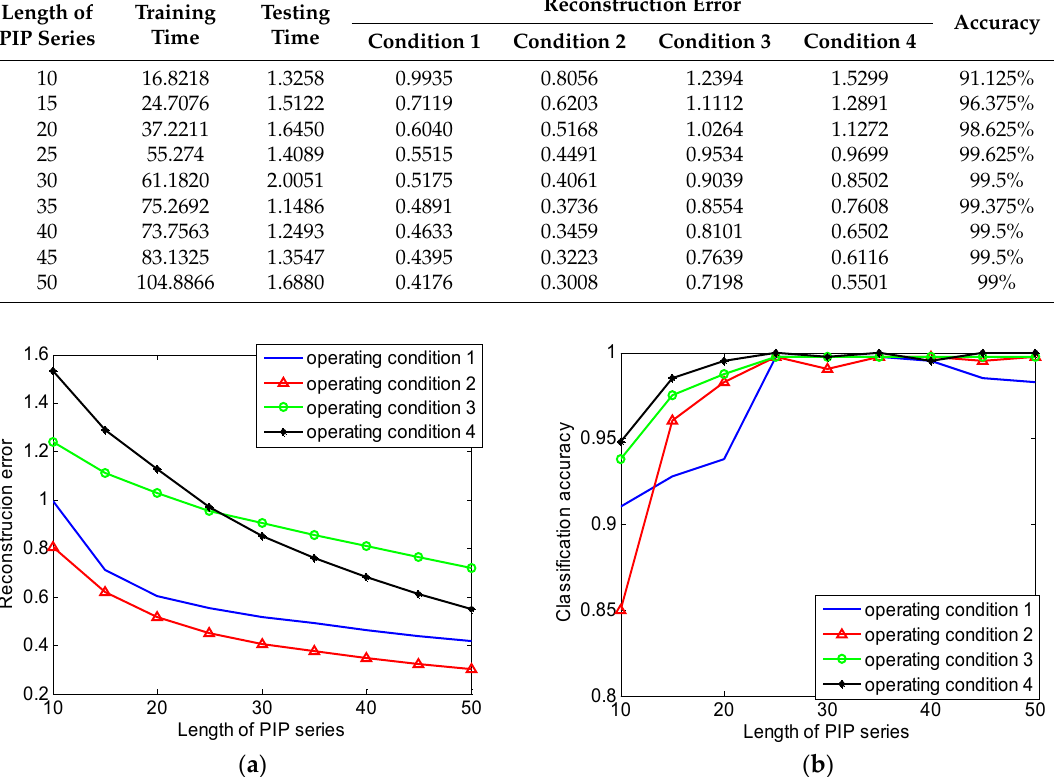
Figure 15. ( a ) The relation between classification accuracy and the length of PIP series; ( b ) The relation between reconstruction error and the length of PIP series.